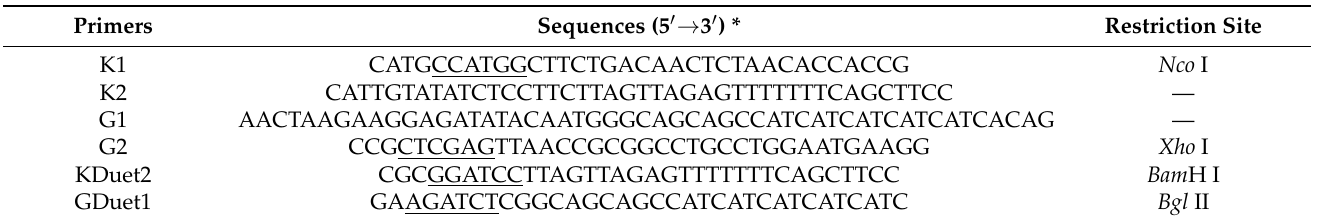
Table 1. Primers used in this